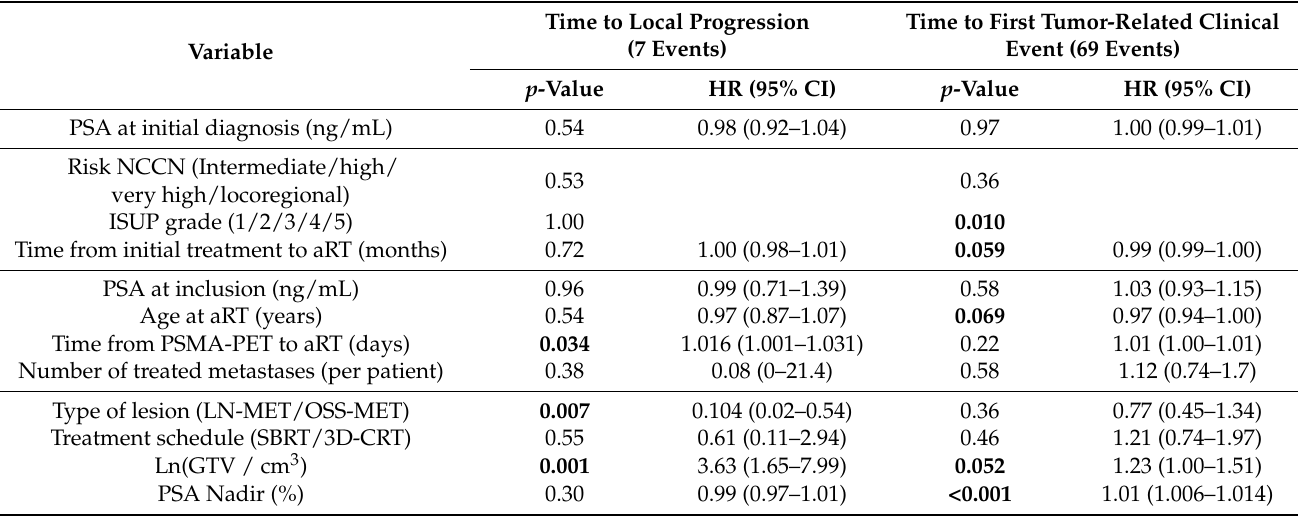
Table 4. Univariate Cox regression analysis for local progression and time to first tumor-related clinical event after aRT.